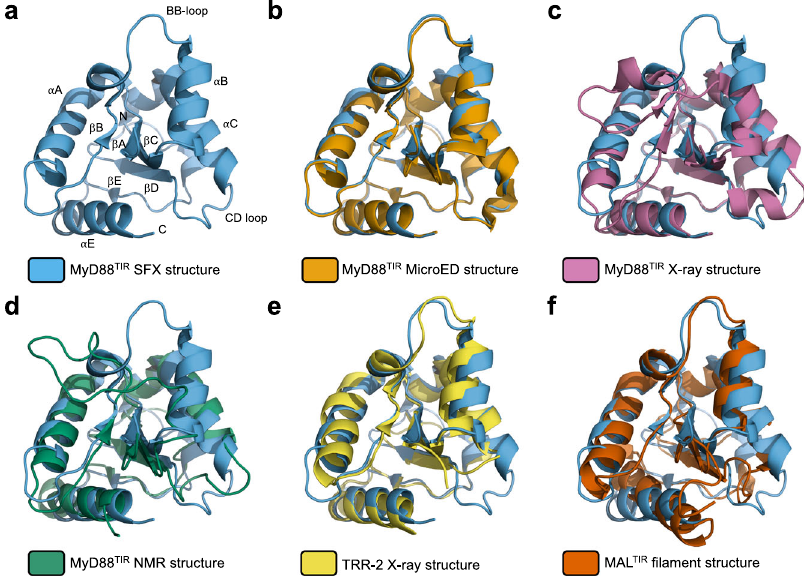
Fig. 3 MyD88 TIR structure comparison. a Ribbon diagram (blue) of a monomer from the MyD88 TIR higher-order assembly structure. Structural elements are labelled sequentially in TIR domains, with the BB-loop connecting strand β B with helix α B, according to the established nomenclature 129 . b – f Superposition of the MyD88 TIR SFX structure (blue), with b the MyD88 TIR MicroED structure (orange); c the monomeric MyD88 TIR X-ray crystal structure (PDB ID 4EO7; magenta); d the monomeric MyD88 TIR NMR solution structure (PDB ID 2Z5V; green); e the crystal structure of the TIR domain of the Toll-related receptor TRR2 from the lower metazoan Hydra vulgaris (PDB ID 4W8G; yellow); and f the MAL TIR higher-order assembly cryo-EM structure (PDB ID 5UZB; red).